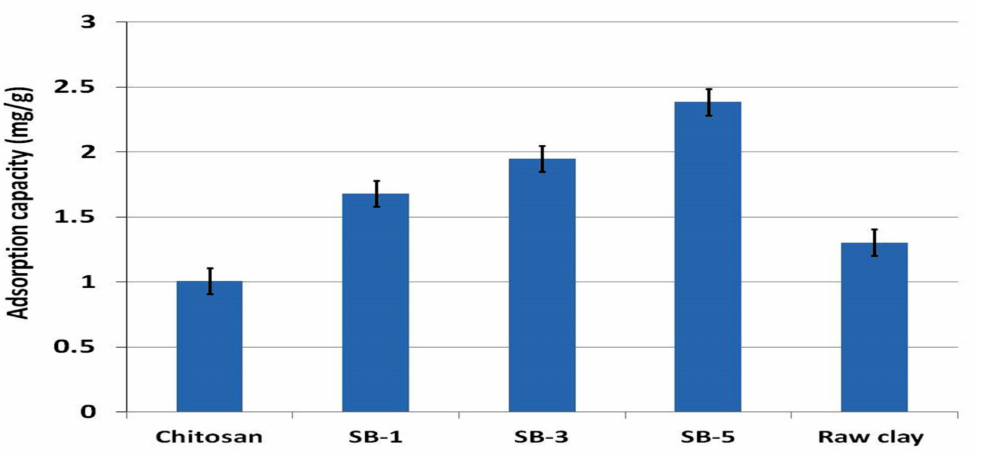
Figure 6. Methylene blue dye removal from standard solution by adsorbents.